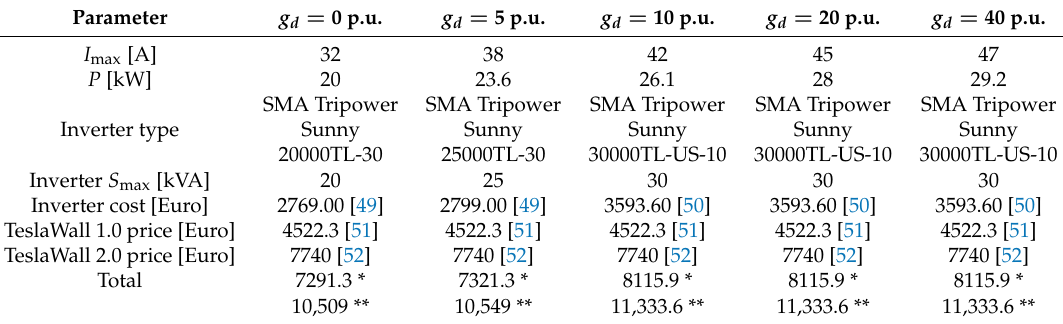
Table 5. Maximum current ratings of the power electronic inverters as a function of the damping conductance and